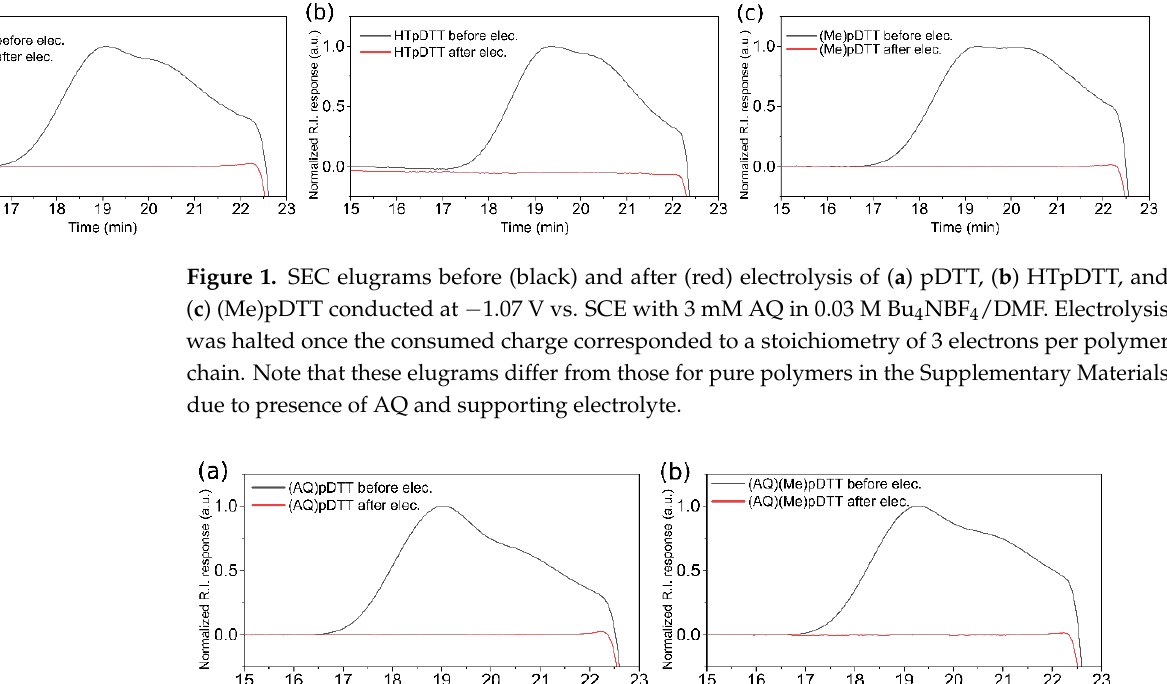
Figure 2. SEC elugrams before (black) and after (red) electrolysis of ( a ) (AQ)pDTT and ( b ) (AQ)(Me)pDTT pDTT conducted at − 0.92 V vs. SCE in 0.03 M Bu 4 NBF 4 /DMF. Electrolysis was halted once the charge consumed corresponded to a stoichiometry of 3 electrons per polymer. Note that these elugrams differ from those of pure polymers in the Supplementary Materials due to presence of supporting electrolyte.